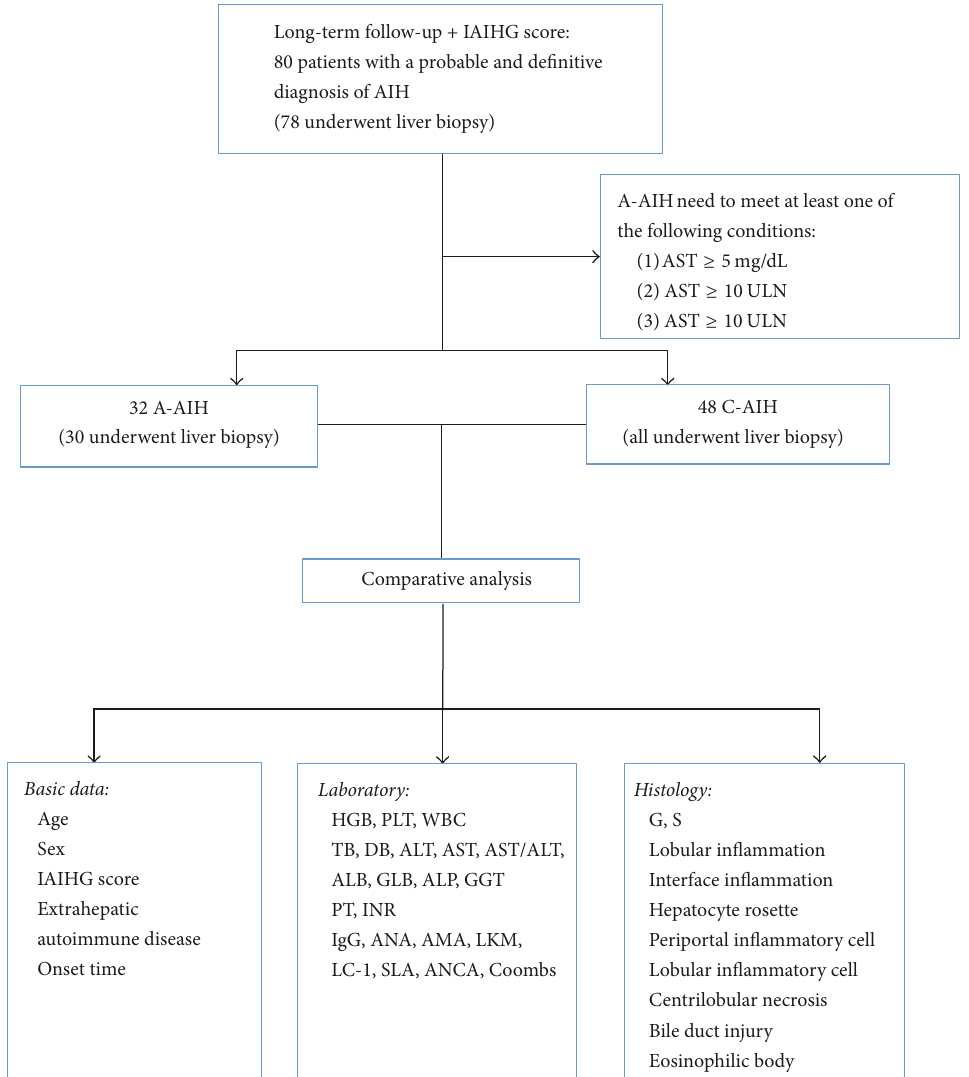
Figure 1: Flow chart . The figure shows the entire process and the contents of the study. IAIHG: international autoimmune hepatitis group; AIH: autoimmune hepatitis; A-AIH: acute presentation-autoimmune hepatitis; TB: total bilirubin; ALT: alanine aminotransferase; AST: aspartate transaminase; C-AIH: chronic autoimmune hepatitis; HGB: haemoglobin; PLT: platelet; WBC: white blood cell; DB: direct bilirubin; ALB: albumin; GLB: globulin; ALP: alkaline phosphatase; GGT: gamma-glutamyl transferase; PT: prothrombin time; INR: international normalized ratio; IgG: immunoglobulin G; ANA: anti-nuclear antibody; AMA: anti-mitochondrial antibody; LKM: liver kidney microsomal; LC: liver cytosol; SLA: soluble liver antigen; ANCA: anti-neutrophil cytoplasmic antibody; Coombs: Coombs test; G: inflammation grade; S: fibrosis